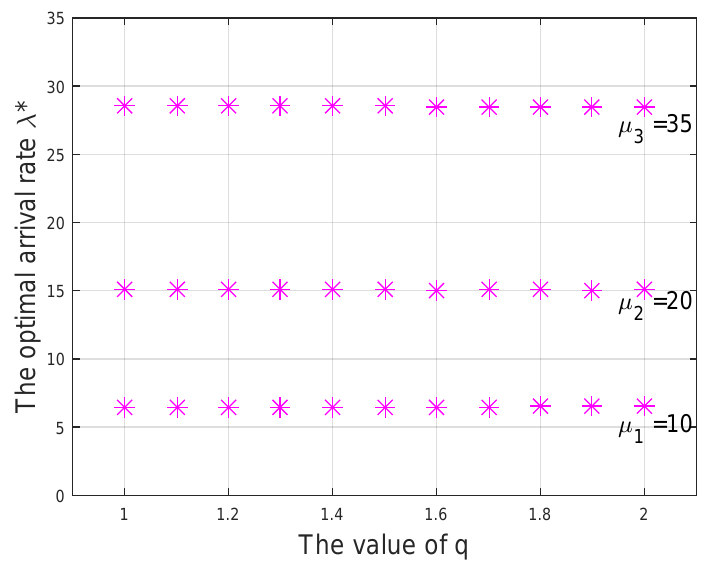
Figure 6. The optimal allocation rate with a changing value of q .